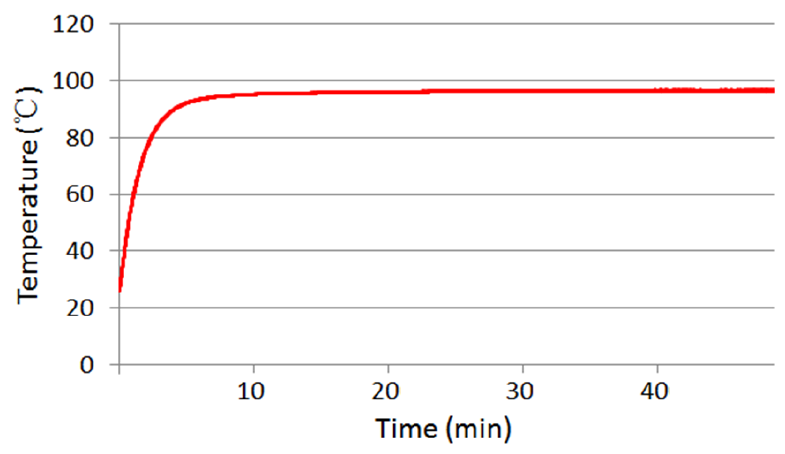
Figure 5. Thermal time-response of the temperature calibration capillary tube.